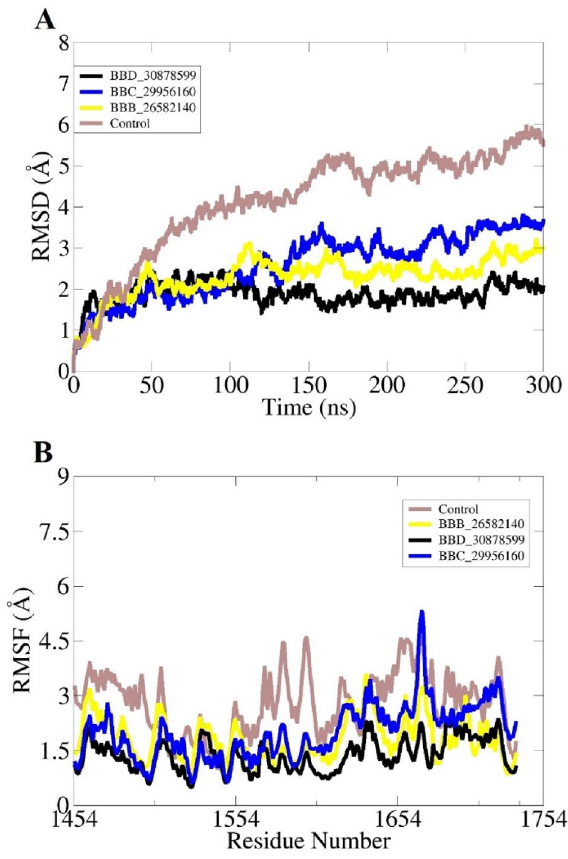
Figure 5. Dynamic investigation of docked complexes. ( A ) structure stability RMSD and ( B ) residue flexibility RMSF.